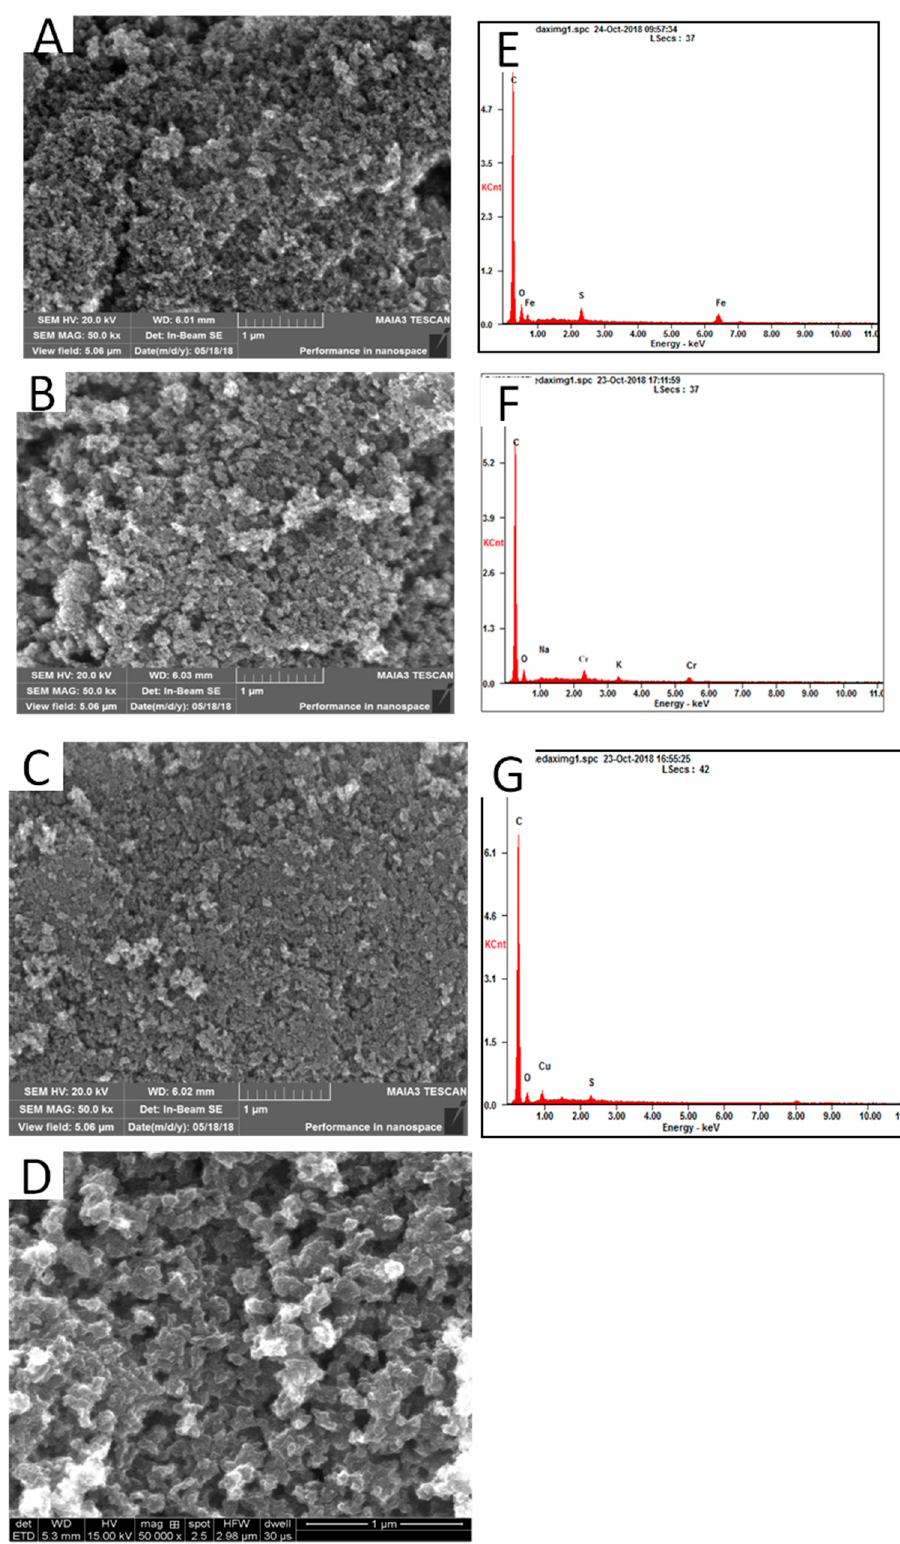
Figure 6. SEM images of CA-X ( A ) CA-Fe ( B ) CA-Cr ( C ) CA-Cu and ( D ) Blank, EDS of CA-X ( E ), CA-Fe ( F ) and CA-Cr ( G ).